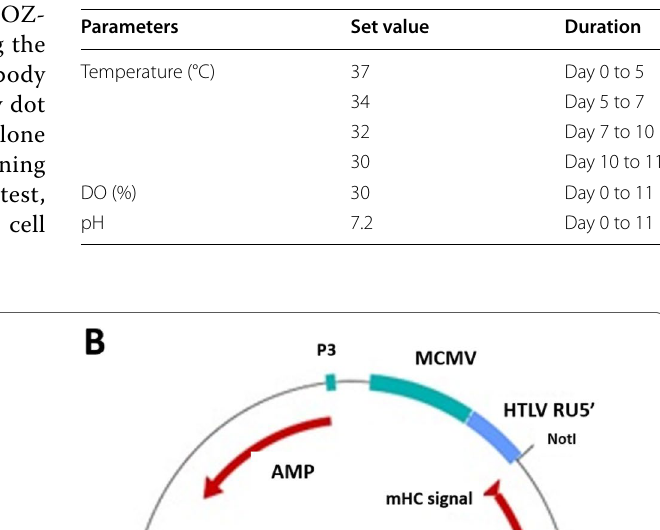
Table 1 Details of process parameters of the 5000 mL